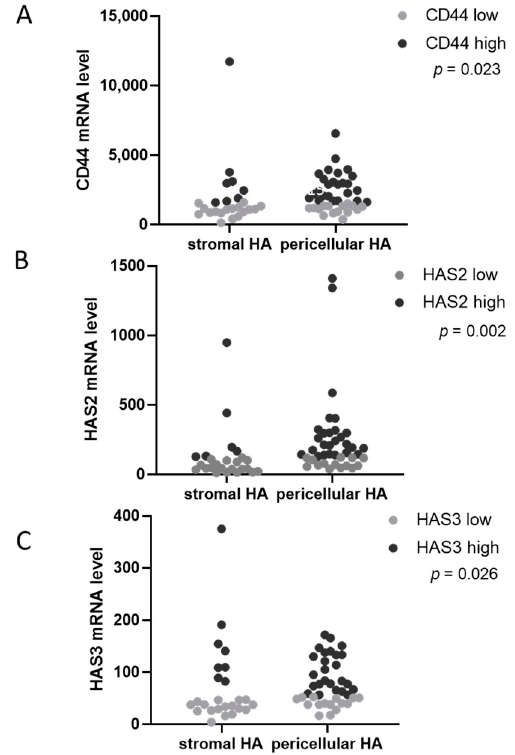
Figure 3. Correlations between HA-deposition pattern and expression of HA-related genes. Tumors displaying an ovarian cancer-cell pericellular hyaluronan deposition pattern showed higher mRNA levels of ( A ) CD44, ( B ) HAS2 and ( C ) HAS3. p values after chi-square tests are provided; p < 0.05 was regarded as significant.